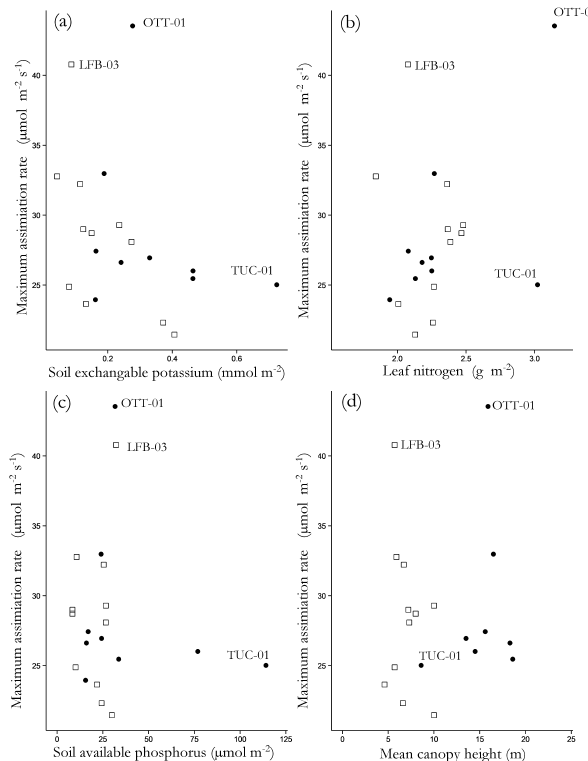
Figure 11. Relationships of community-abundance-weighted mean maximum CO 2 assimilation rates to (a) soil exchangeable potas- sium, community-abundance-weighted foliar nitrogen concentra- tions (area basis), (c) soil available phosphorus and (d) mean canopy height. Selected plots (specifically mentioned in the text) are also shown. ( • ) Forest plots; ( (cid:3) ) savanna